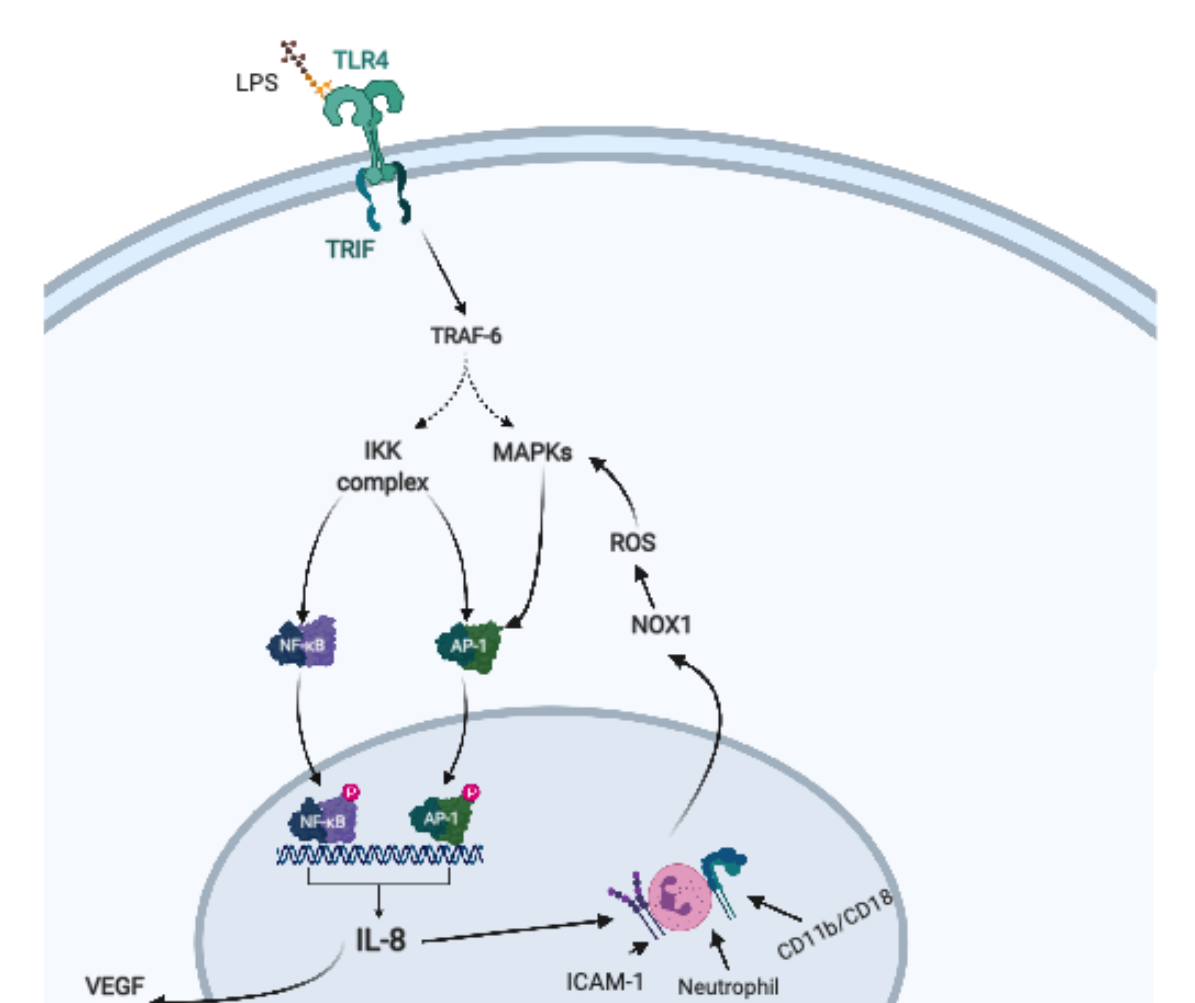
Figure 2. The relationship between IL-8 and gastric carcinogenesis. Created with BioRender.com (https://biorender.com/) IL-8 expression is upregulated as a result of H. pylori infection and plays a central role in the development of gastric cancer. This cytokine is released after activation of NF-kB- and AP-1- dependent pathways. Its chemotactic properties for neutrophils will eventually facilitate formation of a tetrameric network (CD11b/CD18/neutrophil/ICAM-1), which will induce ROS release through activation of NOX-1. ROS damage epithelial cells and stimulate MAPKs, which further enhance AP-a transcription and, subsequently, IL-8 release. The cytokine is also responsible for VEGF release, with angiogenic properties. Legend: AP-1 — activator protein 1; ICAM-1 — intercellular adhesion molecule-1; IKK —IκB kinase; IL— interleukin; LPS — lipopolysaccharide; MAPK — mitogen-activated protein kinase; NF-kB — nuclear factor kappa B; NOX-1 — neutro-